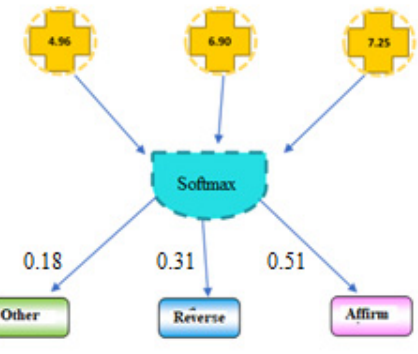
Figure 11. Classification of court judgments.